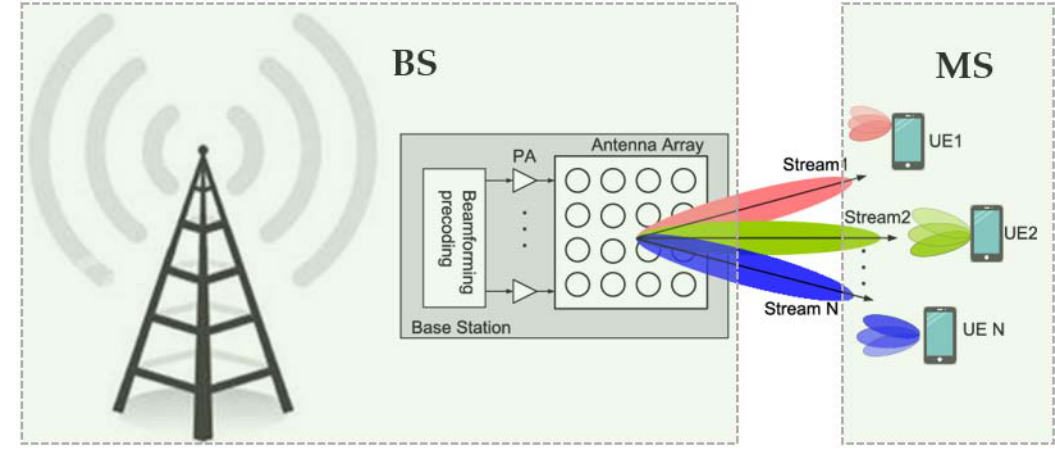
Figure 4. Beamforming antenna array scenario at BS and MS.